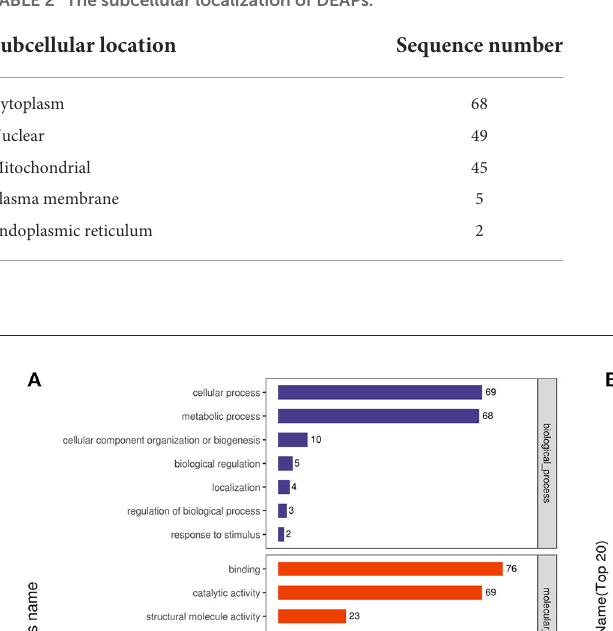
FrontiersinSustainableFoodSystems